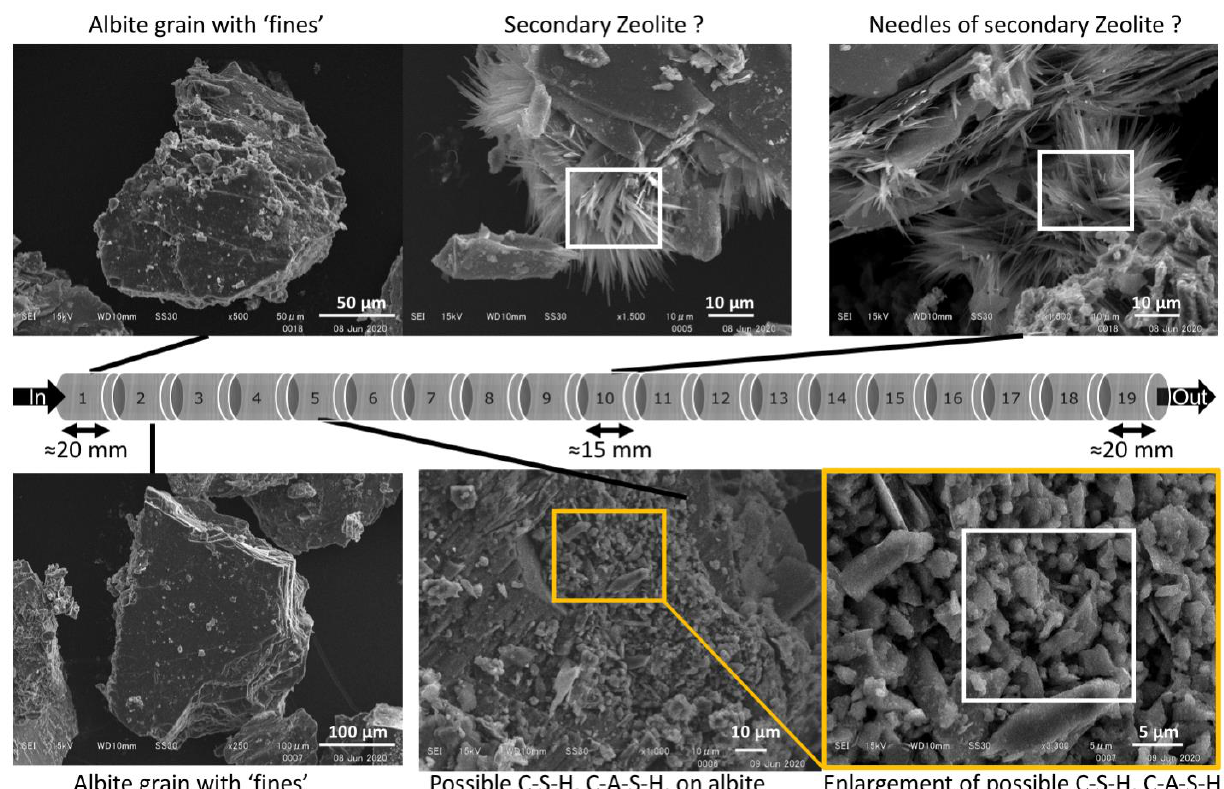
Figure 5. Summary of mineralogy of Toki granite with ‘young’ OPC leachate (Col-1). All SEM photos are secondary electron (SE) images. The white rectangle in the SEM images indicate the areas used for SEM–EDS analysis (see Figure S2b–d). Orange rectangle indicates the area enlarged in the adjacent image.